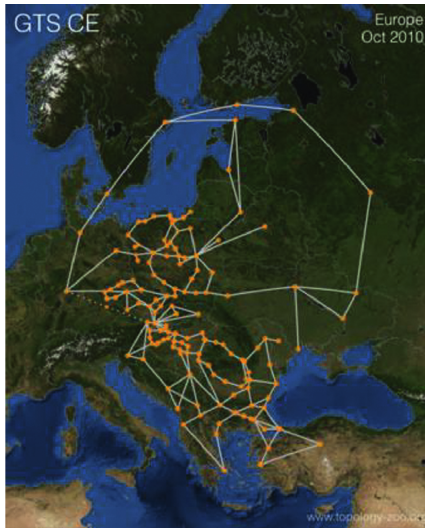
Figure 1: The GTS network topology used for simulation, including 130 nodes and 168 links.